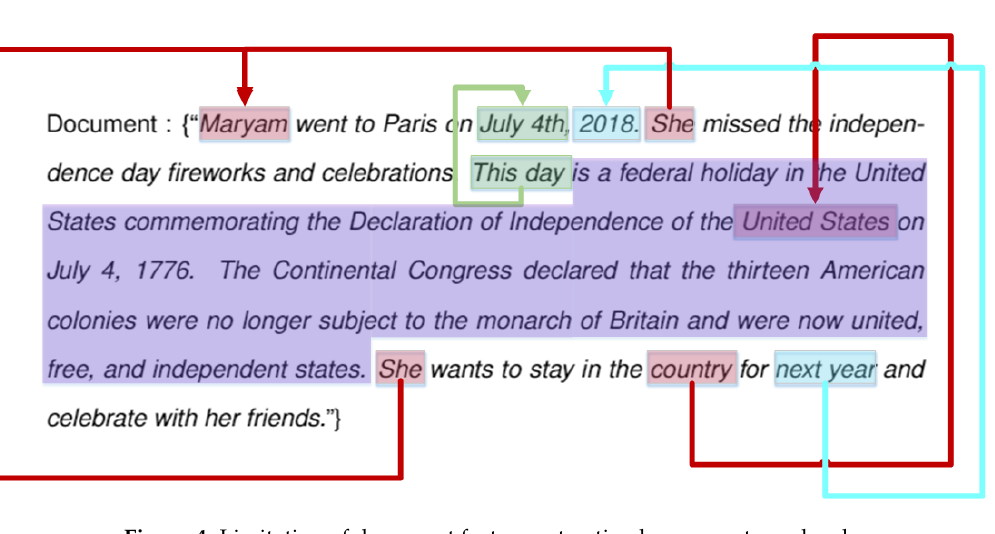
Figure 4. Limitation of document feature extraction by per-sentence